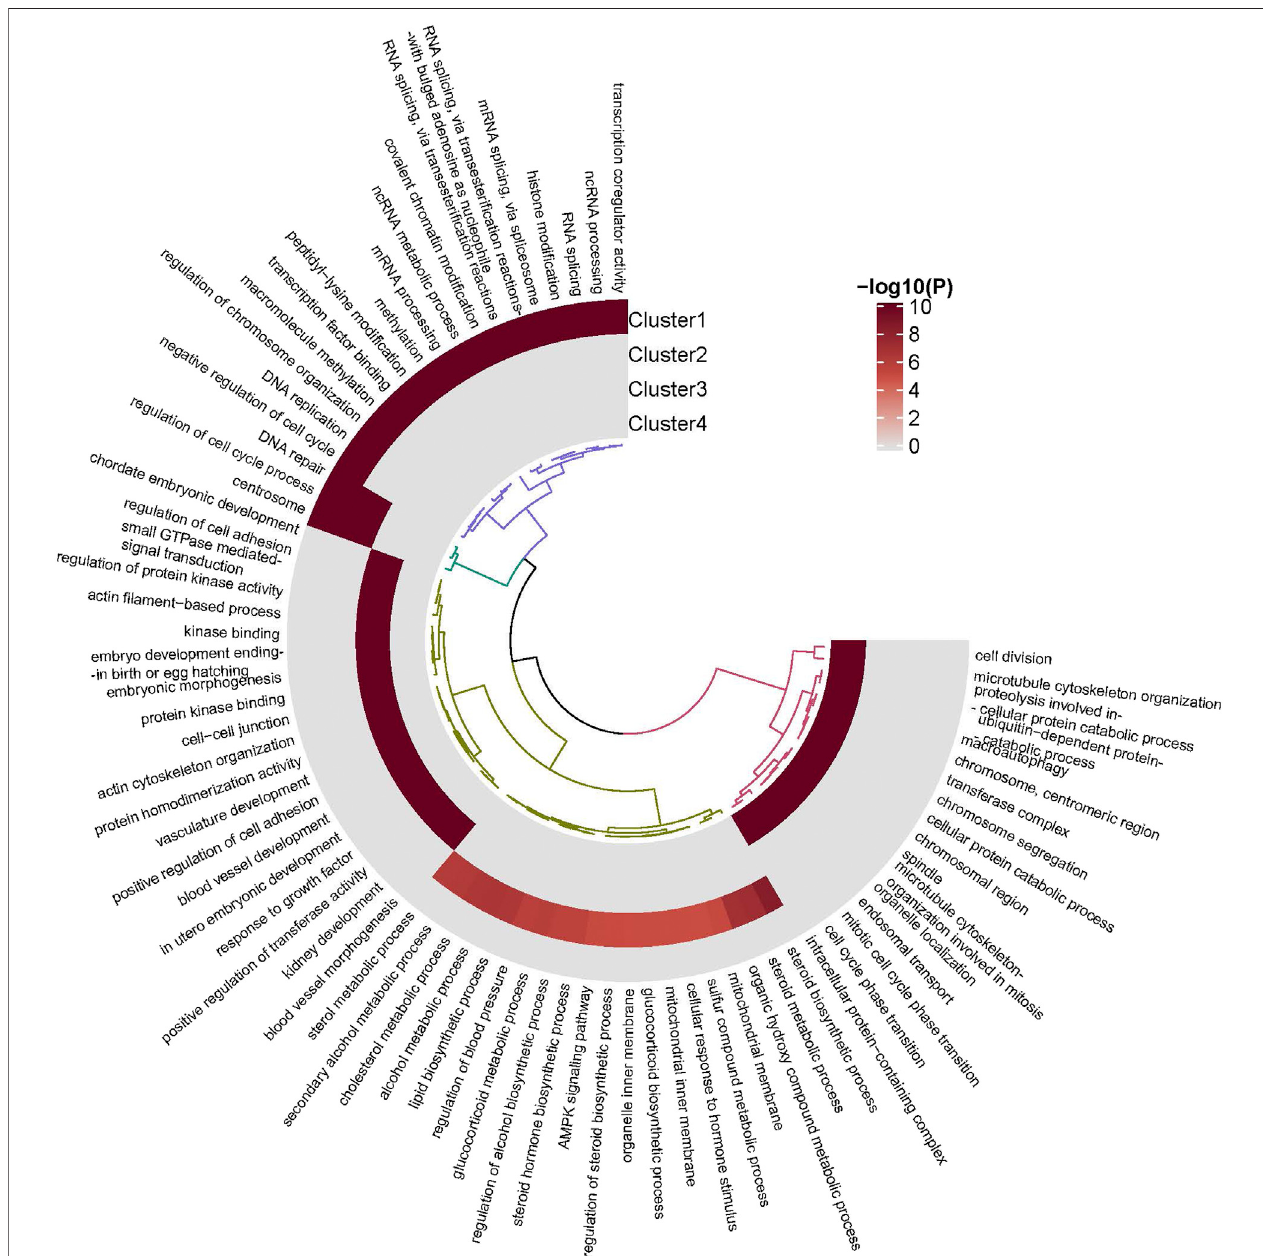
FIGURE 5 | The gene enrichment for the 4